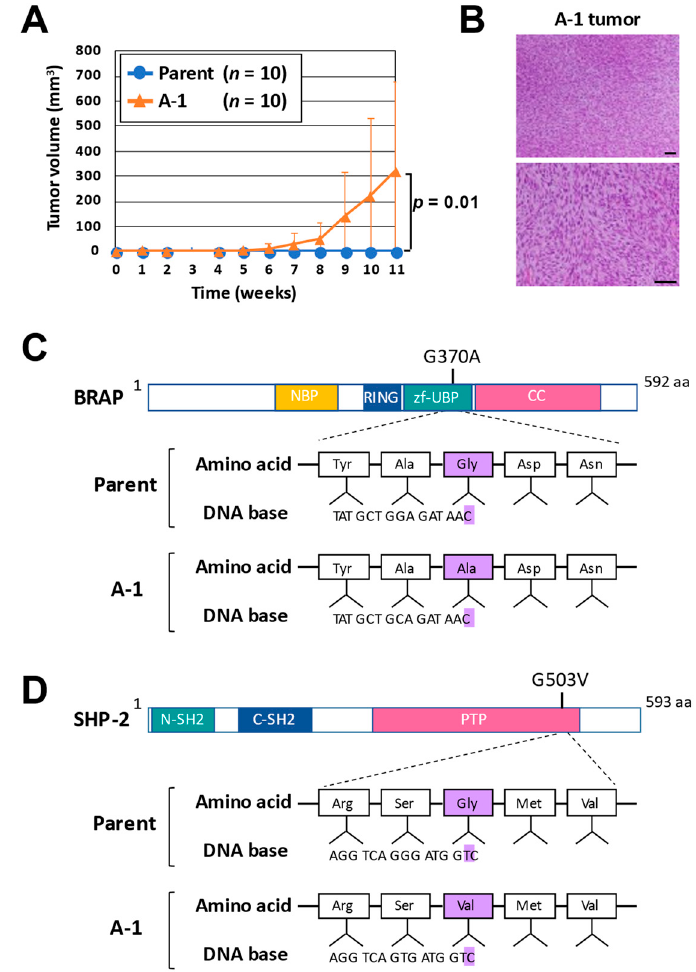
Figure 2. Identification of genetic alterations related to NF1 tumor malignancy. ( A ) Tumor volume measured at the indicated times after subcutaneous injection of sNF96.2-GFP (parent) or A-1 cells (5 × 10 6 ) into Balb/c nu/nu mice. Data are means ± SD ( n = 10 mice), and the p value was calculated with the two-tailed unpaired Student’s t test. ( B ) Representative hematoxylin–eosin staining of a tumor formed at 11 weeks after subcutaneous injection of A-1 cells. Scale bars, 100 µm. ( C ) Domain organization of human BRAP and location of the amino acid difference between sNF96.2-GFP (parent) and A-1 cells. BRAP encodes BRCA1-associated protein (BRAP, also known as RNF52, BRAP2, and IMP), which contains a nucleotide-binding a/b plait (NBP) domain, a really interesting new gene zinc finger (RING) domain, a ubiquitin-specific protease (UBP)-like zinc finger (zf-UBP) domain, and a coiled-coil (CC) domain and functions as a RAS-responsive E3 ubiquitin ligase [21]. ( D ) Domain organization of human SHP-2 and location of the amino acid difference between sNF96.2-GFP (parent) and A-1 cells. PTPN11 encodes protein tyrosine phosphatase nonreceptor type 11 (SHP-2), which contains an NH 2 -terminal SRC homology 2 (N-SH2) domain, a COOH-terminal SRC homology 2 (C-SH2) domain, and a protein tyrosine phosphatase (PTP) domain